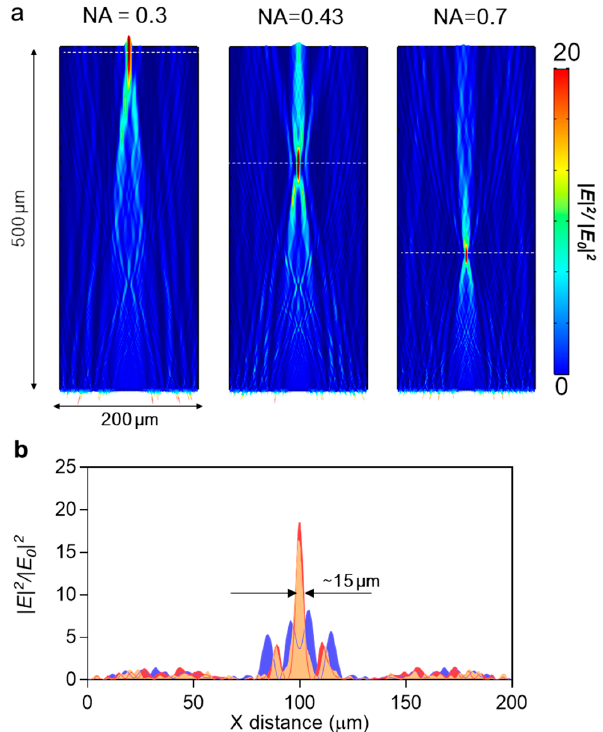
Figure 3. ( a ) COMSOL simulation of light intensity distribution with various numerical apertures (NAs). ( b ) Enhancement ratio profile across the focused area (white dashed line in Figure 2a).